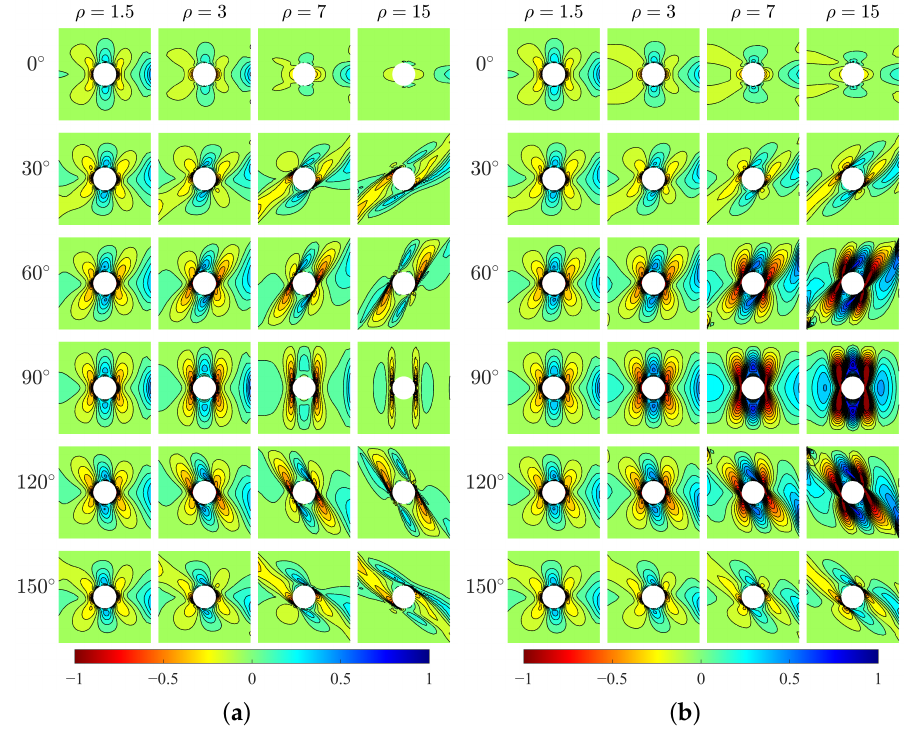
Figure 6. Vertical stress σ 22 , MPa, ( a ) Cosserat, ( b )